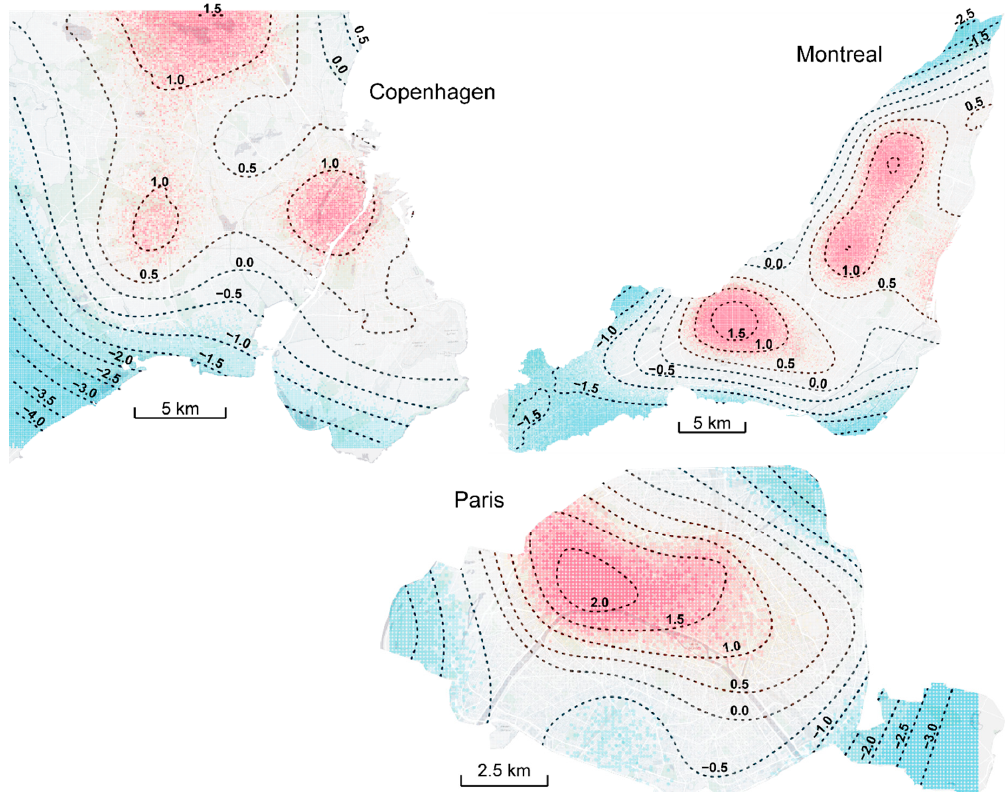
Figure 6. Marginal effects of space on noise exposure prediction for the three cities. The marginal effect represents the spatial deviation from the overall mean. These maps allow to identify places where noise exposure levels are lower or higher through space, all other things being equal.